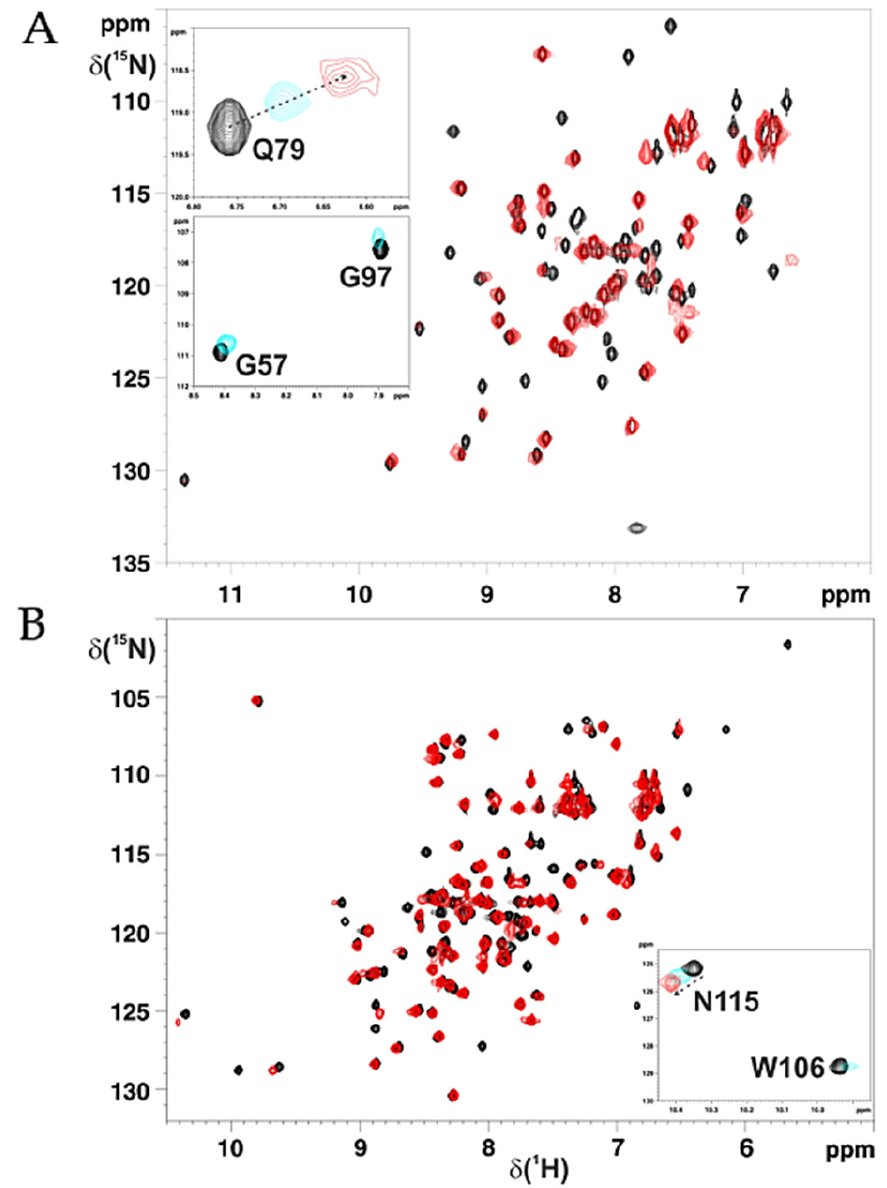
Figure 2. NMR showed apo hetero-complex formation between C59Y BOLA3 and GLRX5. ( A ) Overlay of the 1 H − 15 N HSQC spectra of 15 N-labelled C59Y BOLA3 (starting protein concentration 800 µ M, black) and of a 1:1 15 N-labelled C59Y BOLA3-unlabelled apo GLRX5 mixture (red). In the insets, the overlay of 1 H − 15 N HSQC spectra of 15 N-labelled C59Y BOLA3 at 0.0 (black), 0.5 (cyano), and 1.0 (red) equivalents of unlabeled apo GLRX5 is reported, showing backbone NHs of residues in fast (Q79) and intermediate (G57 and G97) exchange regimes relative to the NMR time scale. ( B ) Overlay of the 1 H − 15 N HSQC spectra of 15 N-labelled apo GLRX5 (starting protein concentration 800 µ M, black) and of a 1:1 15 N-labelled apo GLRX5-unlabelled C59Y BOLA3 mixture (red). In the inset, the overlay of 1 H − 15 N HSQC spectra of 15 N-labelled apo GLRX5 at 0.0 (black), 0.5 (cyano), and 1.0 (red) equivalents of unlabeled apo C59Y BOLA3 is reported, showing backbone NH of N115 in a fast exchange regime relative to the NMR time scale and the NH of the indole ring of W106 in an intermediate exchange regime relative to the NMR time scale. The 1 H − 15 N HSQC spectra were acquired at 298 K in 150 mM NaCl, 5 mM GSH, 5 mM DTT, 50 mM phosphate buffer (pH 7.0), and 10% ( v / v ) D 2 O. As following step, chemical shift perturbations and line broadening analyses were performed by comparing the 1 H − 15 N HSQC spectra of 15 N-labelled BOLA3 and 15 N-la- belled C59Y BOLA3, respectively, with those recorded in presence of equimolar amounts of apo GLRX5, at two different starting concentrations of 15 N-labelled BOLA3 and 15 N- labelled C59Y BOLA3 (100 and 800 μ M). The observed spectral changes were then mapped on the solution structures of BOLA3 (PDB 2NCL) and on a structural model of C59Y BOLA3, obtained by homology modelling through MODELLER 9.10 software fol- lowed by energy minimization in water through AMBER 12.0 program (see the Materials and Methods section for details). In the titrations performed at 100 μ M protein concentration, the spectral analyses showed that very similar interacting regions were identified on both BOLA3 proteins, i.e., wild-type and Cys59Tyr mutant (Figure 3A,B, respectively). These regions included helix α 2 ; strand β 3 ; the loop connecting the latter two elements, which contains His96 Fe–S clus- ter ligand; and a few residues following the Cys59 Fe–S cluster ligand (Figure 3A,B). Com- paring the chemical shifts of the backbone NH signals that were in fast exchange on the NMR time scale on the 1 H − 15 N HSQC spectra of 15 N-labelled BOLA3 and 15 N-labelled